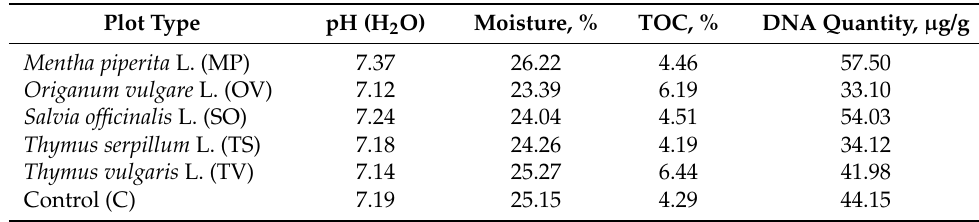
Table 1. Rhizosphere and control samples properties.